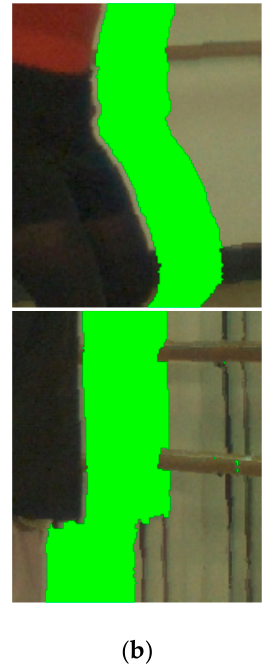
Figure 8. Preprocessing result of actual image: ( a ) Synthesized image without depth image preprocessing; and ( b ) synthesized image after depth image preprocessing.